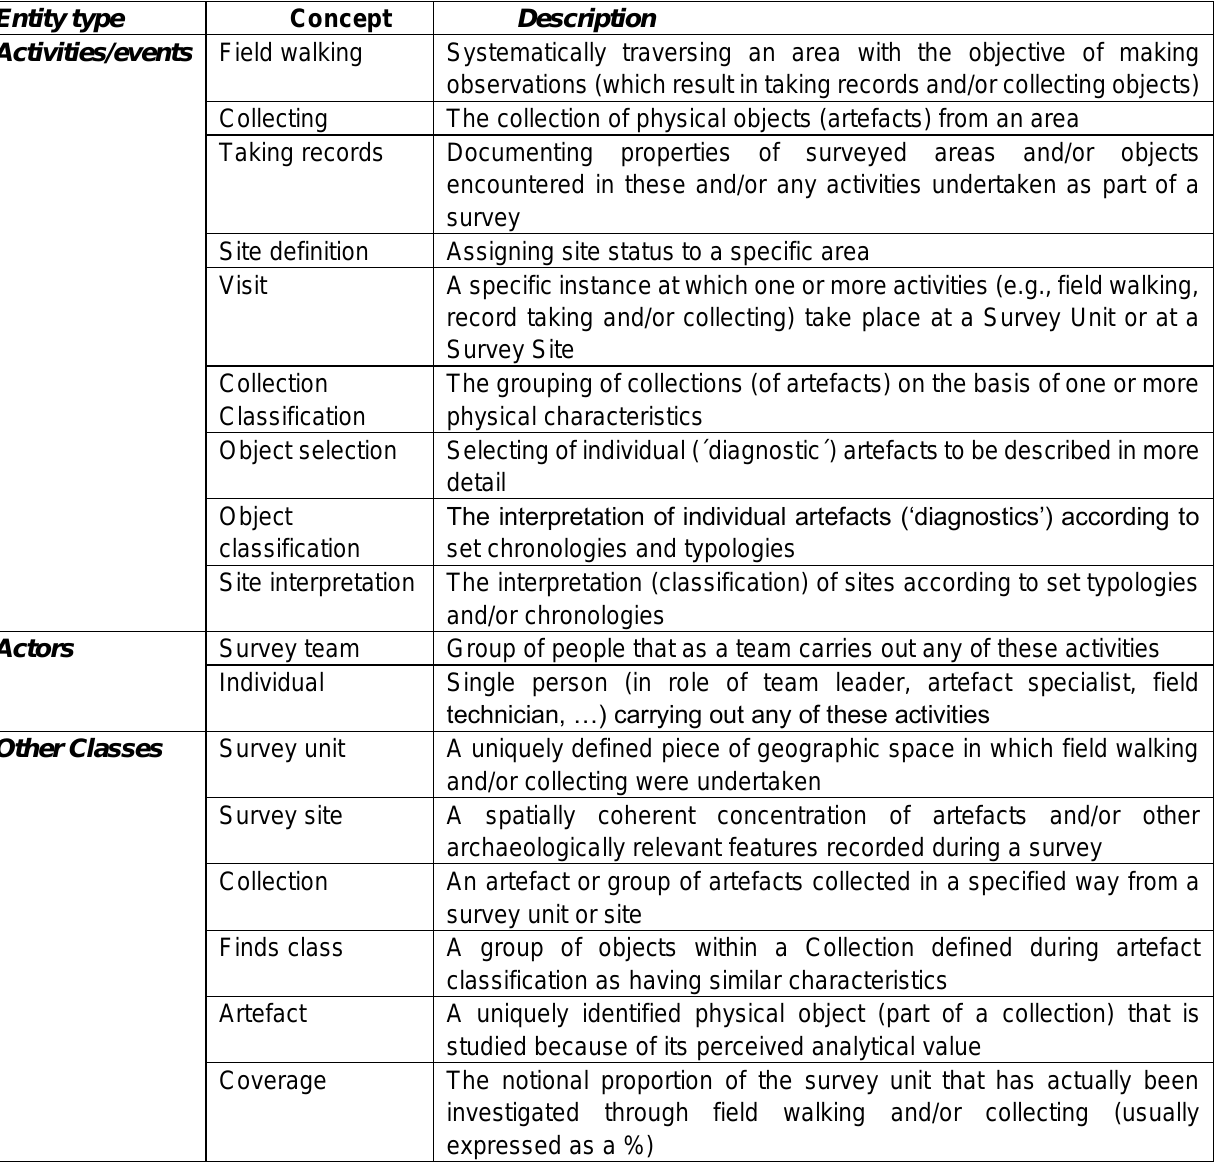
Table 1. Selected concepts needed to describe an archaeological field